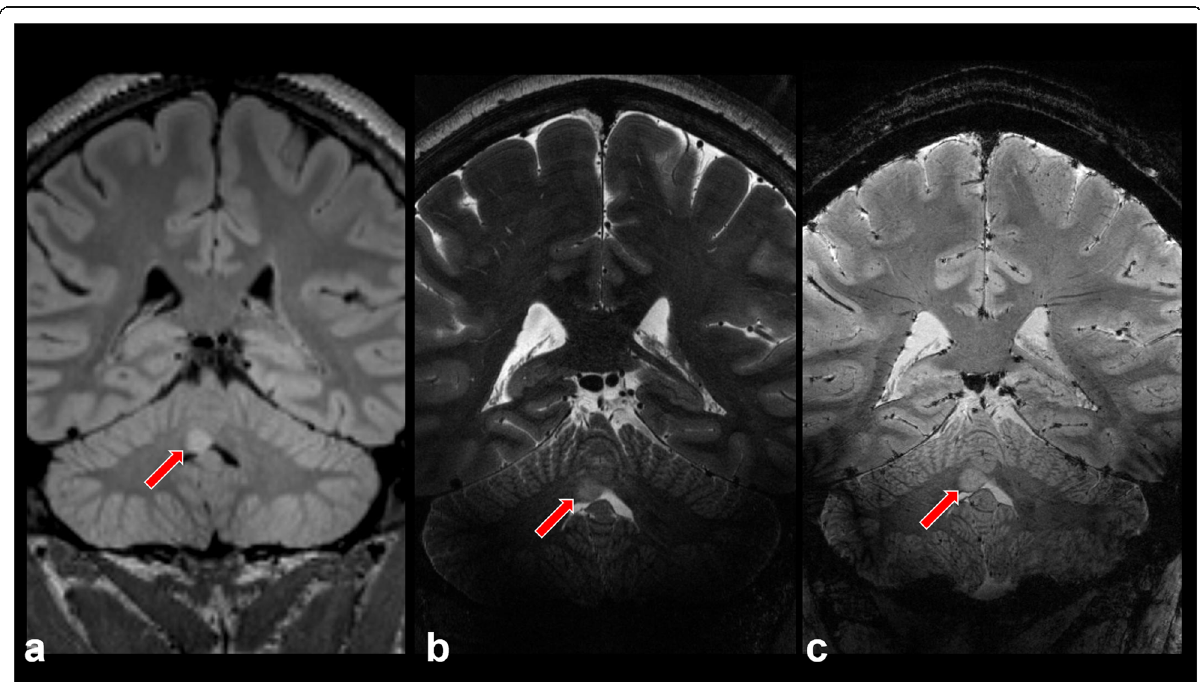
Fig. 6 Hamartoma identified on 3-T magnetic resonance imaging and further characterized at 7 T. Coronal T2-weighted fluid-attenuated inversion-recovery image at 3 T ( a ) demonstrates a hyperintense mass (red arrows) in the right cerebellar vermis. Coronal T2-weighted ( b ) and coronal susceptibility-weighted image ( c ) obtained at 7T show no evidence of microvascularity within the